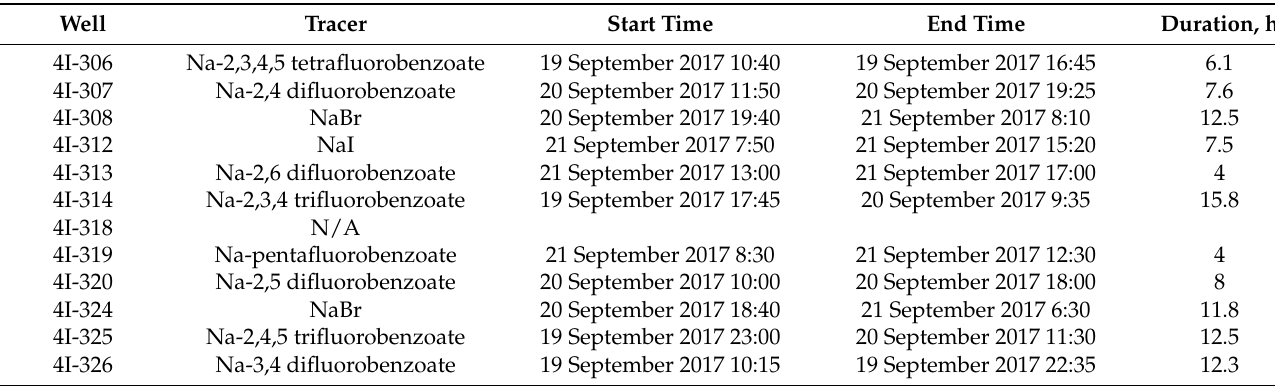
Table A6. Times of tracer injections into each injection